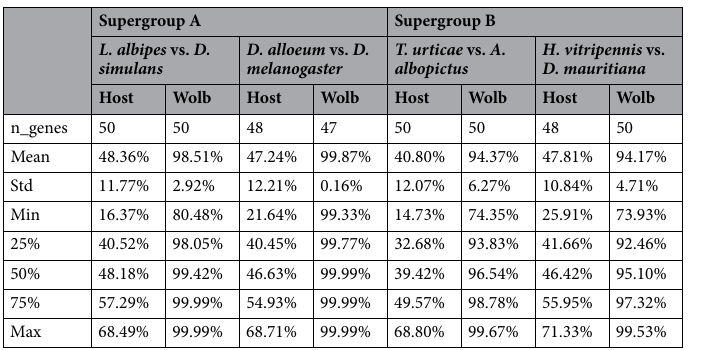
Table 1. Descriptive statistics of pairwise gene sequence similarity of Wolbachia and hosts. n_genes number of genes, std standard deviation, min minimum value found, max maximum value found.